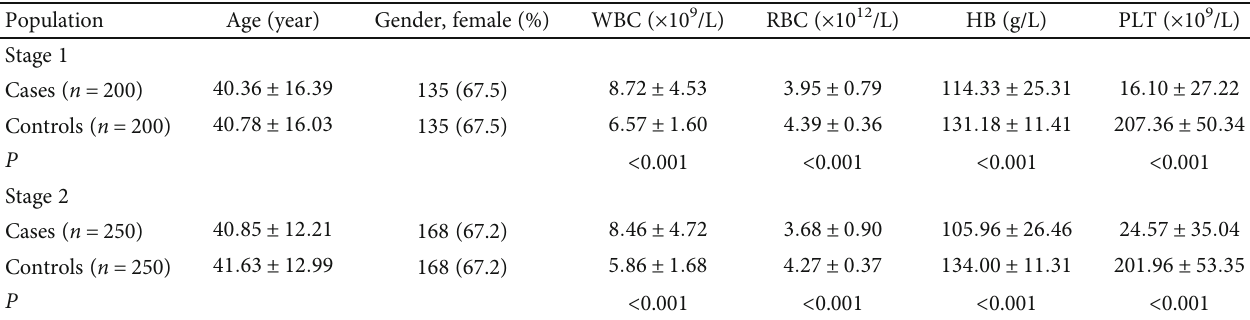
Table 1: Clinical characteristic of ITP patients and controls.